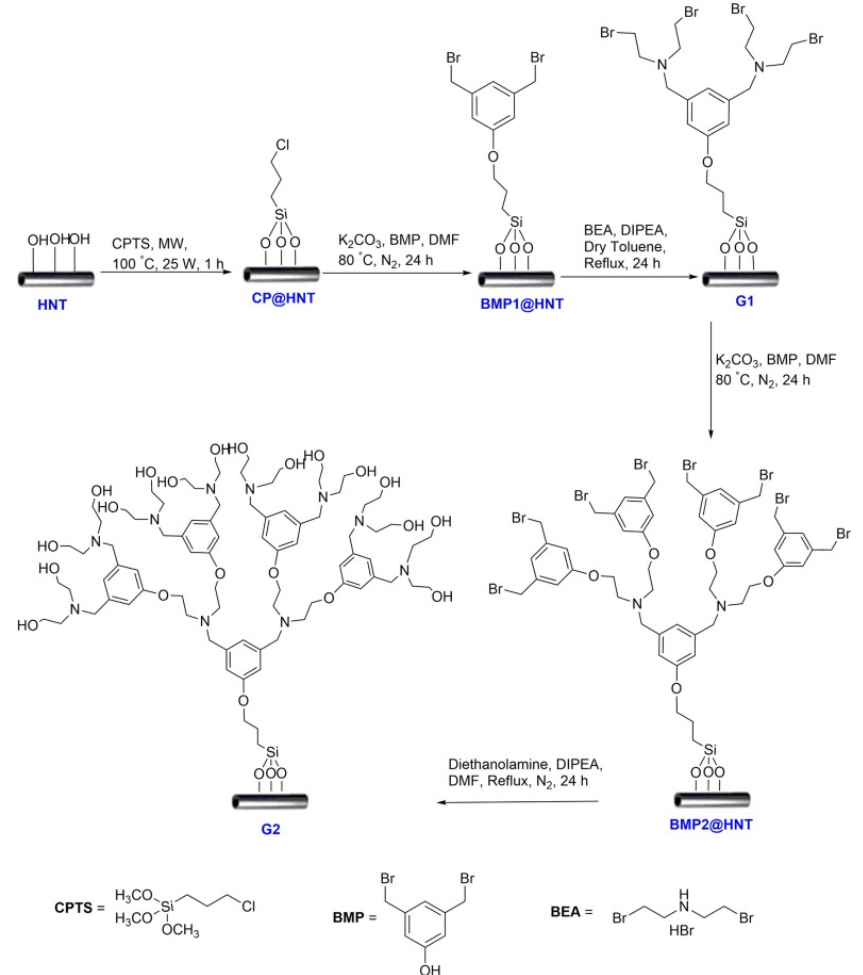
Figure 21. Preparation of halloysite nanotube–functionalized dendrimer. Reproduced with from permission from [164].